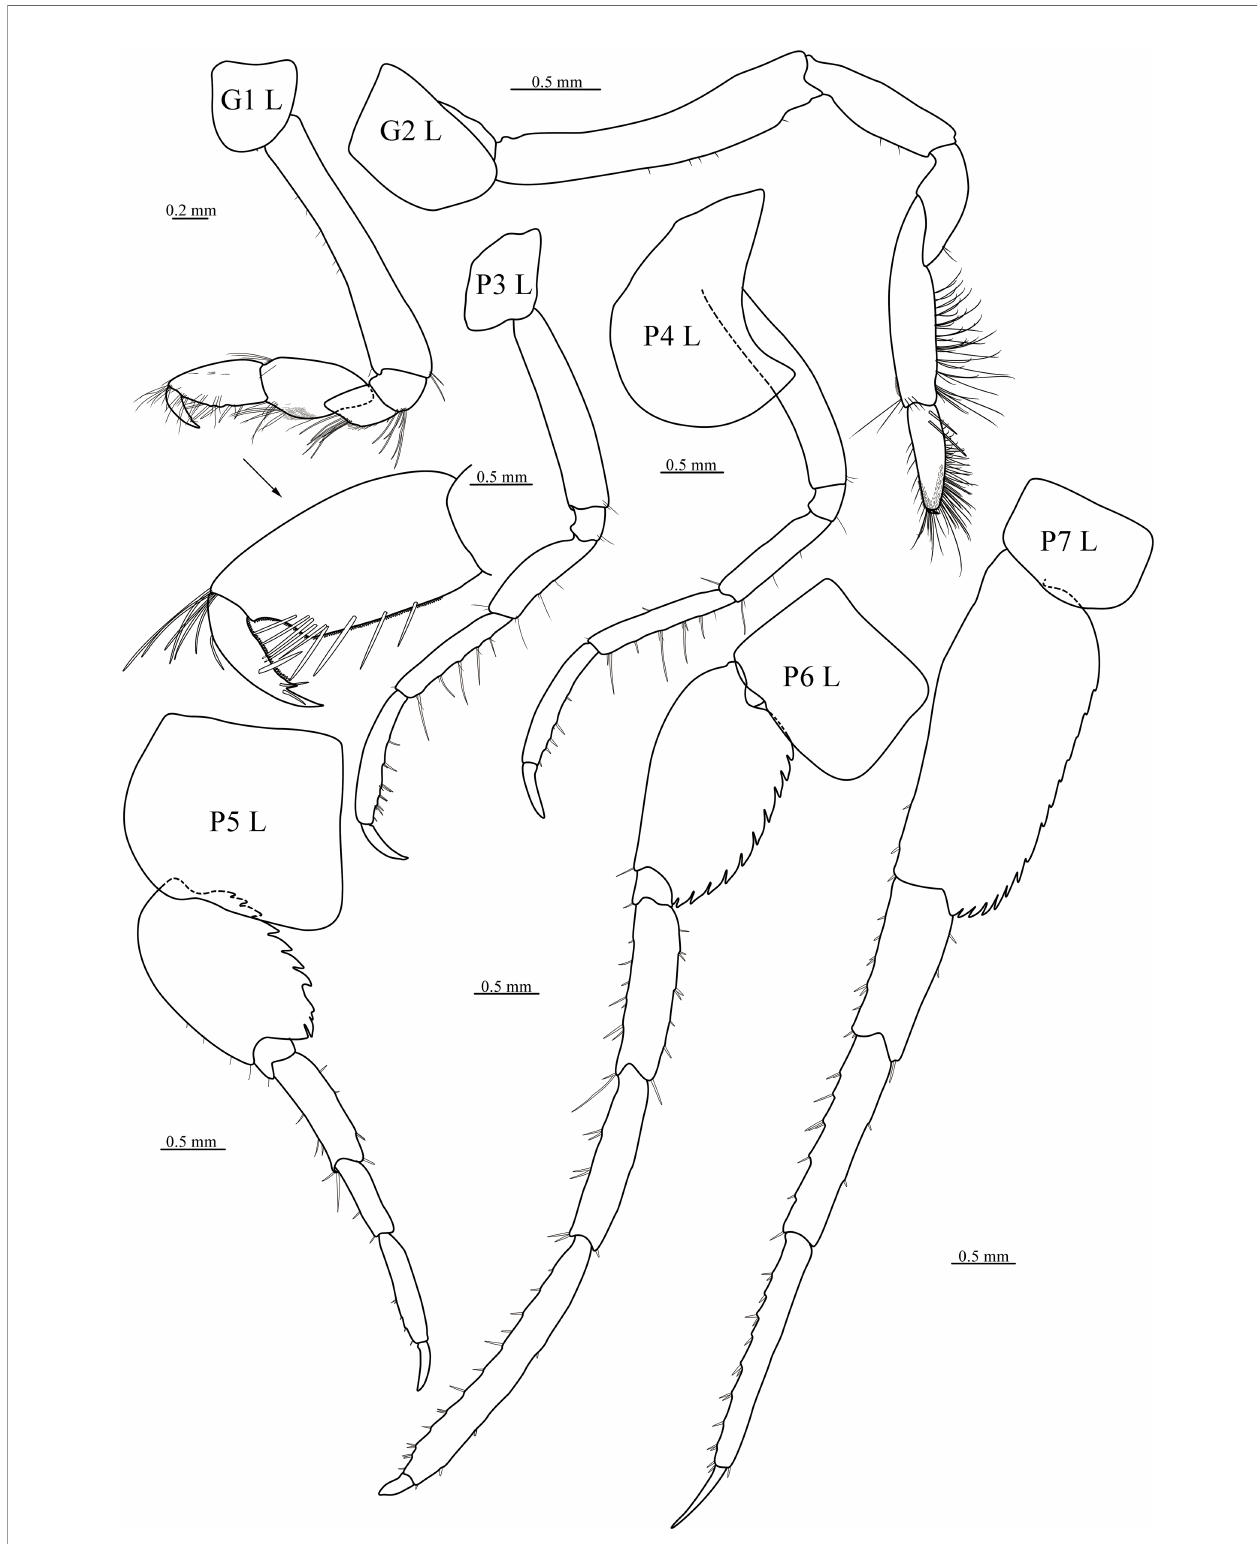
FIGURE 6 | Cyphocaris formosa sp. nov., MBM 286820, male holotype (19 mm), showing gnathopod 1 and 2, pereopod 3 – 7. For abbreviations, see